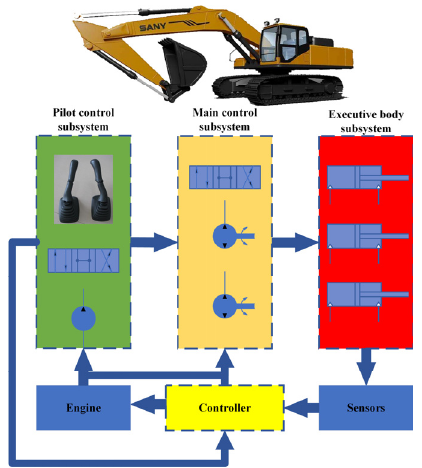
Figure 1. Overview of the SY235C8 hydraulic system.